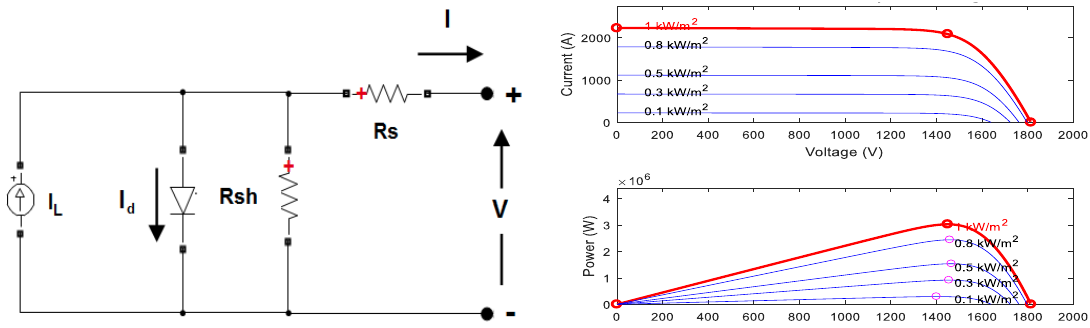
Figure 2. Equivalent circuit of PV cell; I–V and P–V characteristics curves.